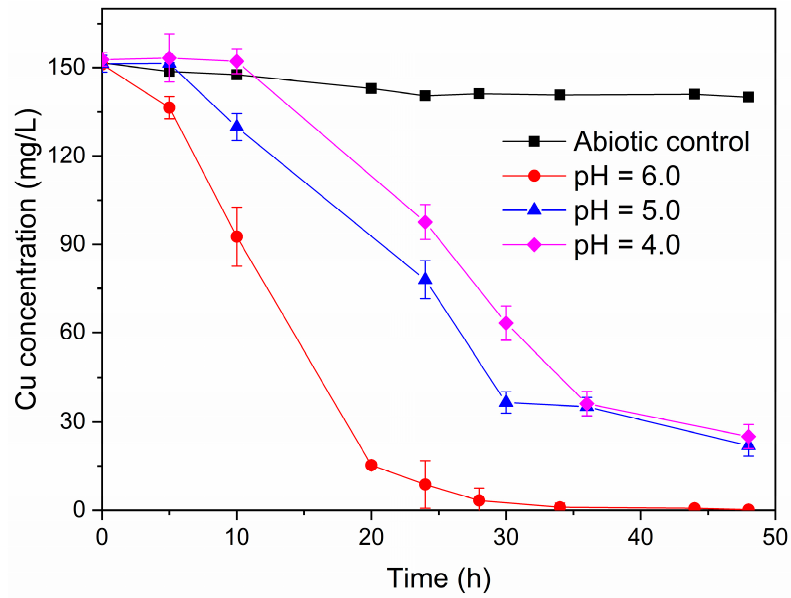
Figure 6. Cu 2+ concentration variation curve in the cathode chamber of dual-chamber MFCs under different anolyte pH conditions.